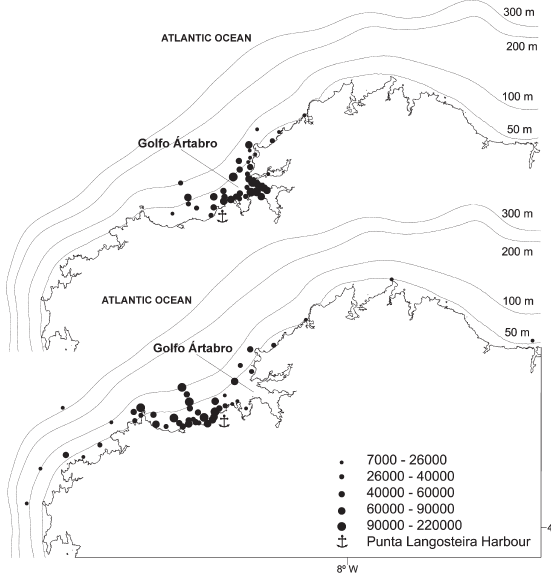
Fig . 4. – Fishing grounds and total revenue (in €) derived from their commercial exploitation in 2004 by the multiple fishing gear fleet with base ports in the north (top) and south